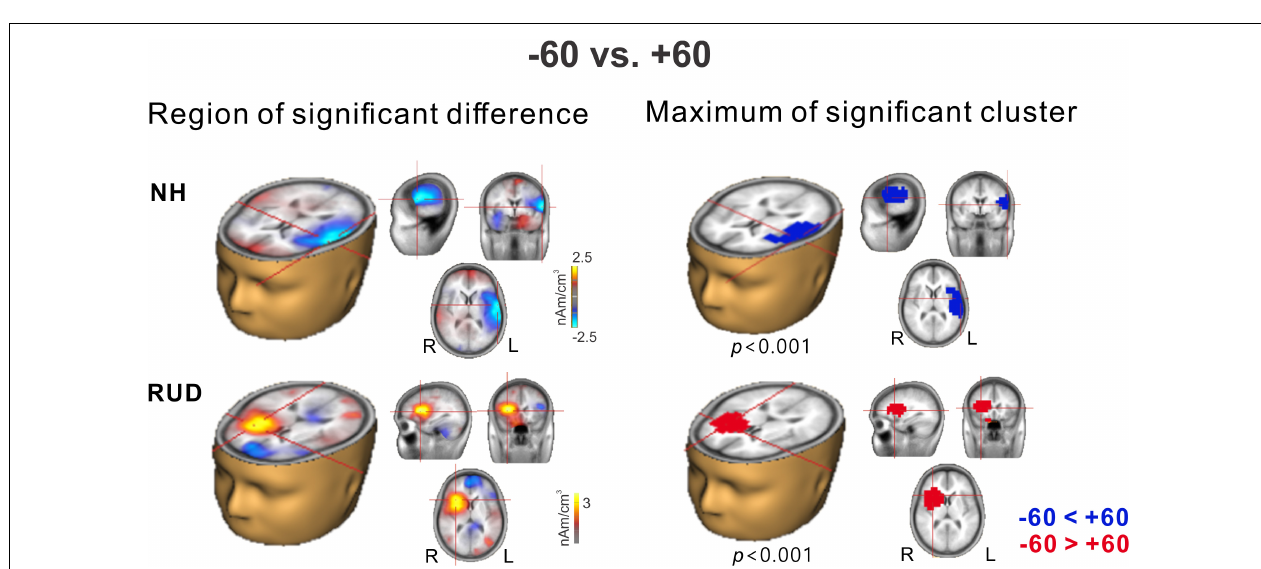
FIGURE 5 | Cluster data representing significant differences between –60 ◦ and +60 ◦ azimuth angles in the brain source space. Blue indicates that +60 ◦ was greater than –60 ◦ (a negative difference) while red indicates that –60 ◦ was greater than +60 ◦ (a positive difference). Note that these clusters indicate which regions showed a significant difference while the crosshairs indicate a 3D point indicating the maximum difference between the azimuth angles. RUD, right-sided unilaterally deaf; NH, normal